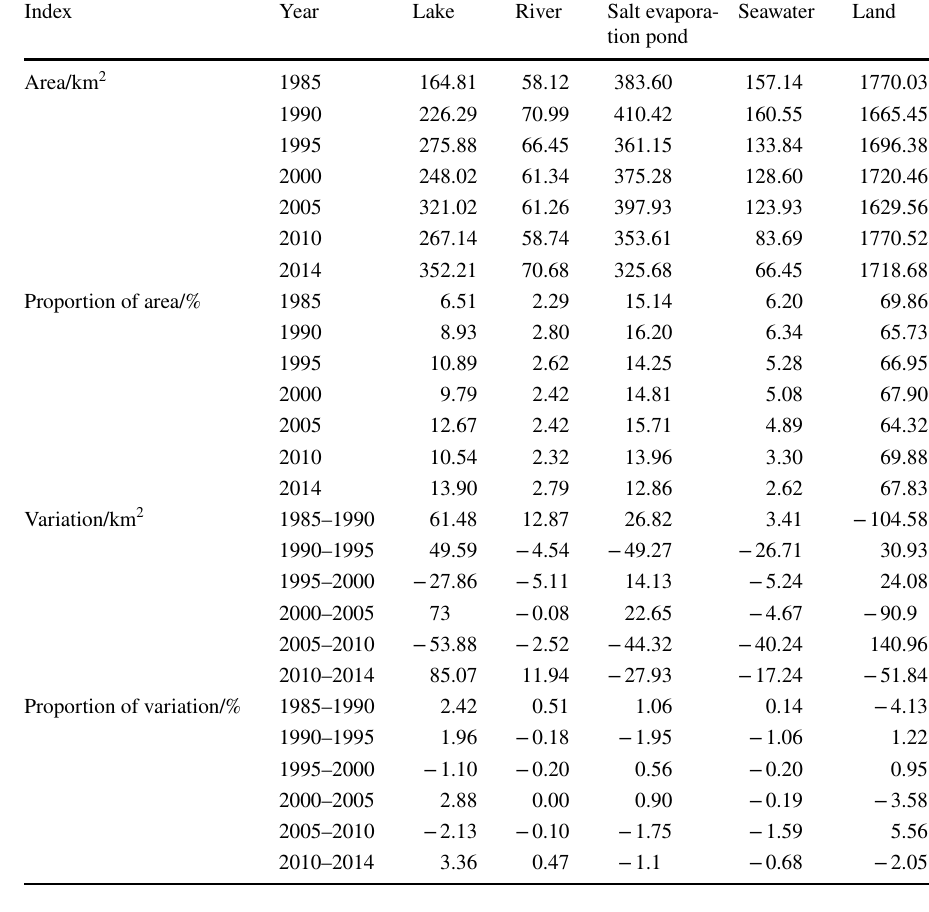
Table 3 Land-use change in the Tianjin Binhai New Area during 1985–2014